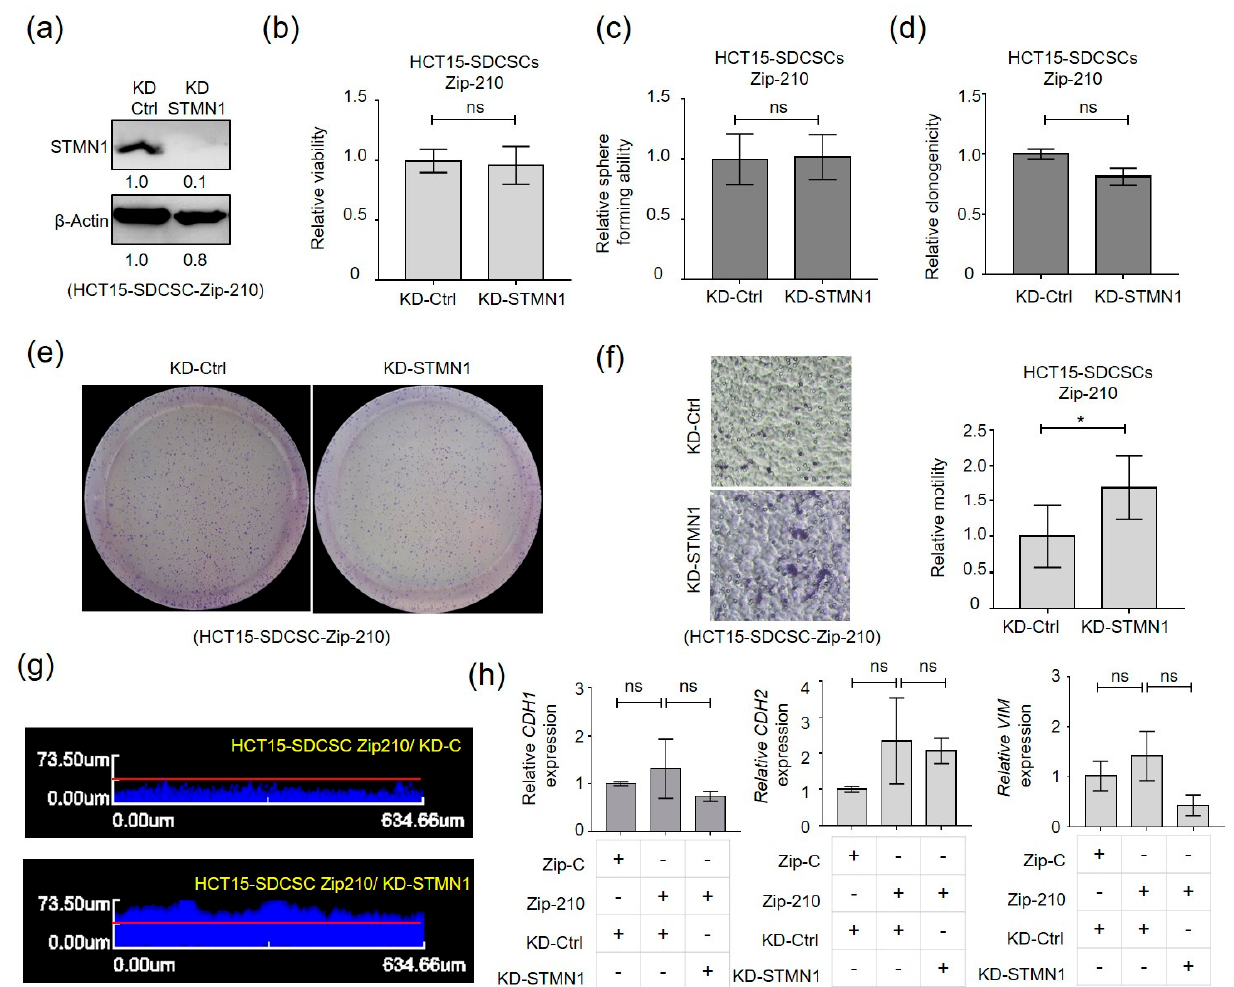
Figure 5. Silencing STMN1 expression restored the attenuated migratory and invasive abilities of miR-210-3p-knockdown SDCSCs. ( a ) Western blots showing the expression of STMN1 in miR-210-3p-knockdown HCT15-SDCSCs. ( b ) Relative viability of cells as assessed by an MTT assay. ns, nonsignificant. ( c ) The sphere-forming capacity of miR-210-3p-silenced HCT15-SDCSCs receiving control shRNA (KD-Ctrl) and shRNA against STMN1 (KD-STMN1). ns, nonsignificant. ( d ) The colony formation ability of miR-210-3p-silenced HCT15-SDCSCs receiving control shRNA (KD-Ctrl) and shRNA against STMN1 (KD-STMN1). ns, nonsignificant. ( e ) Representative images showing colonies generated from the indicated cells. ( f ) Left: representative images of migrated cells. Right: histograms showing the relative transwell migration ability of cells. ( g ) Representative images of vertical invasion of the indicated cells. ( h ) RT-qPCR validation of the expression of an epithelial cell marker (E-cadherin, CDH1) and mesenchymal marker (N-cadherin, CDH2) in control HCT15-SDCSCs, miR-210-3p-silenced HCT15-SDCSCs receiving shRNA control (KD-Ctrl) and miR-210-3p-silenced HCT15-SDCSCs receiving shRNA against STMN1 (KD-STMN1). ns, nonsignificant. Data in bar charts are expressed as the mean ± SD values. * p < 0.05 (Student’s t -test).